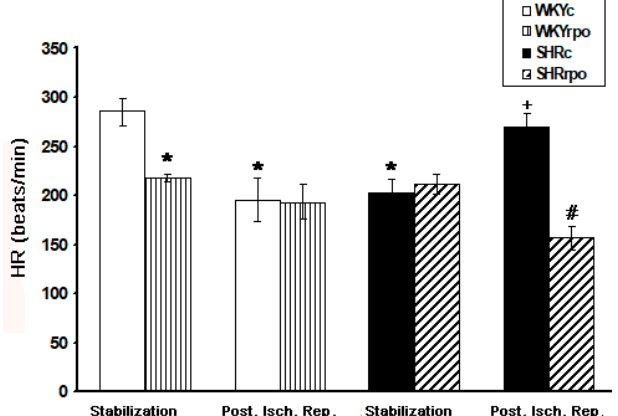
Figure 5. Effect of dietary red palm oil (RPO) supplementation on the heart rate of WKY and SHR during stabilization and post ischemic reperfusion (Post. Isch. Rep). WKYc—Wistar Kyoto control rats; WKYrpo—WKY treated with RPO; SHRc—Spontaneously hypertensive rats; SHRrpo—SHR treated with RPO. Results are expressed as mean ± SEM; n = 6 in each group; * p < 0.05 versus control rats (WKYc); # p < 0.05 WKY/SHR versus treated with RPO; + p < 0.05 SHRc during stabilization versus SHRc during Post. Isch. Rep.